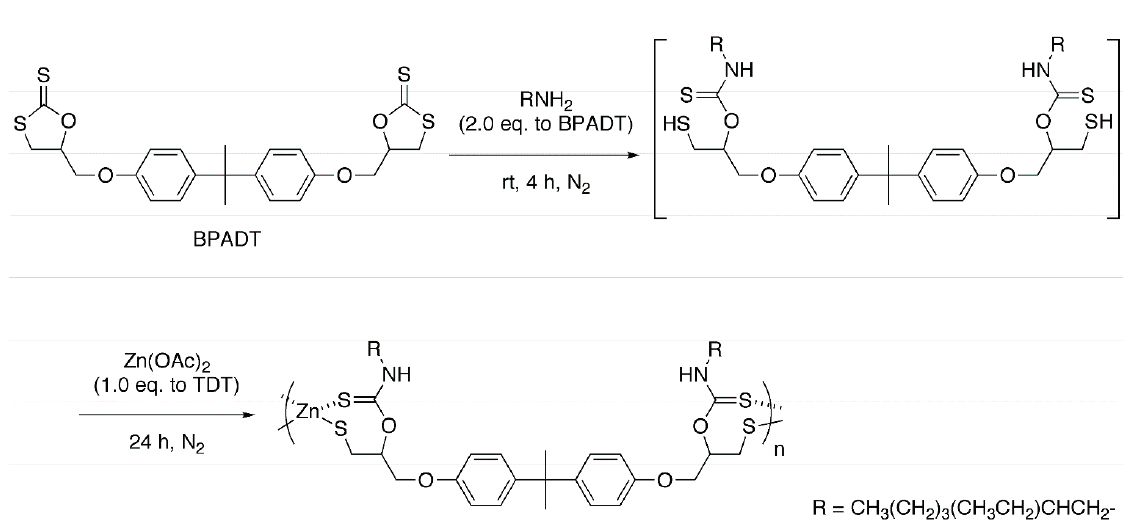
Table 2. One-pot synthesis of organic-sulfur-zinc hybrid via sequential ring-opening addition of EHA and BPADT and polycondensation of the in situ generated thiol with Zn(OAc) 2 . Run Solvent Temperature (°C) R-NH 2 (Equivalent to C=S) Yield (%) a M n ( M w / M n ) b Zn/S c DMSO 30